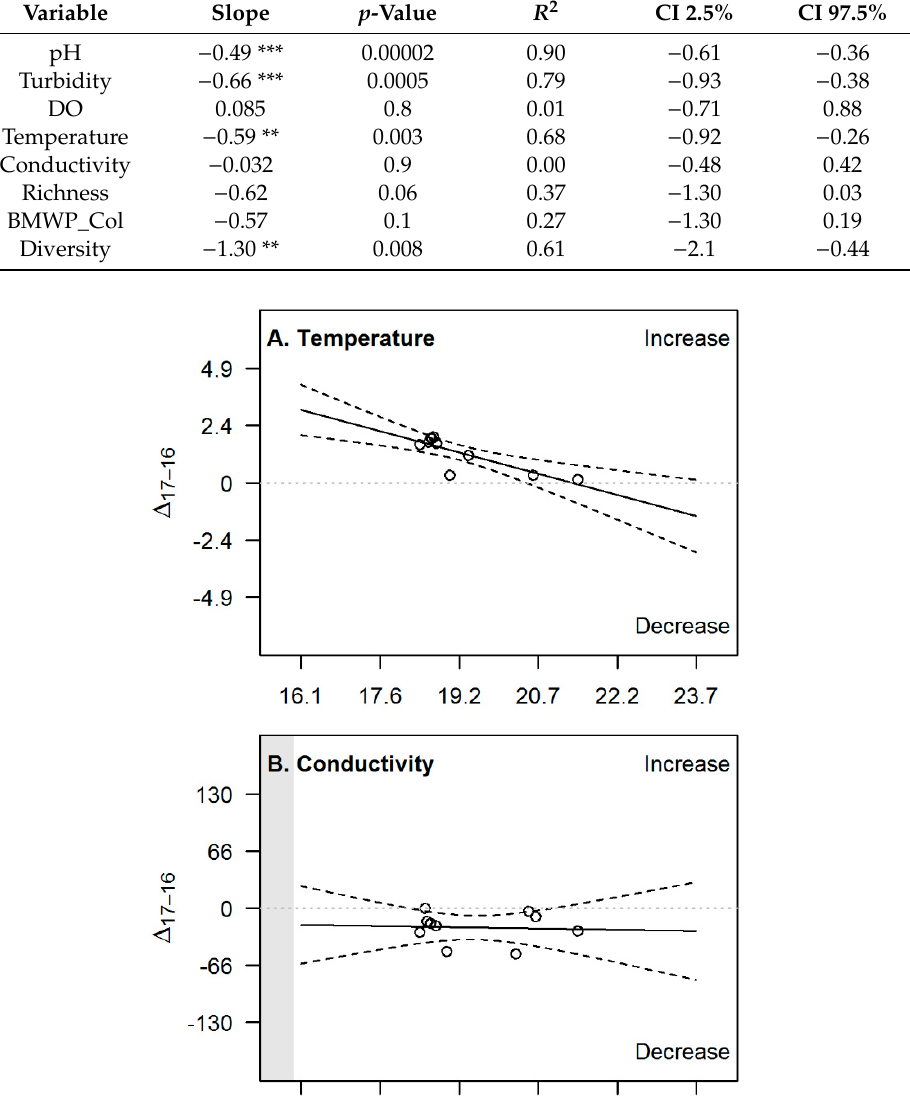
Figure 5. Linear regression lines depicting the change in abiotic variables between 2016 and 2017. Open circles represent the sample sites, the solid black line the fitted trend, and the dotted black lines the confidence (95%) related to it. ( A ) Temperature (°C); ( B ) conductivity (µS cm − 1 ). Only temperature differences were characterized by a significant slope value ( − 0.59, p = 0.003). Conductivity values in 2017 were significantly lower than values recorded in 2016 ( p = 0.002). The depicted x -range covered 2.5 times the initial range, thereby including negative values (gray zones).